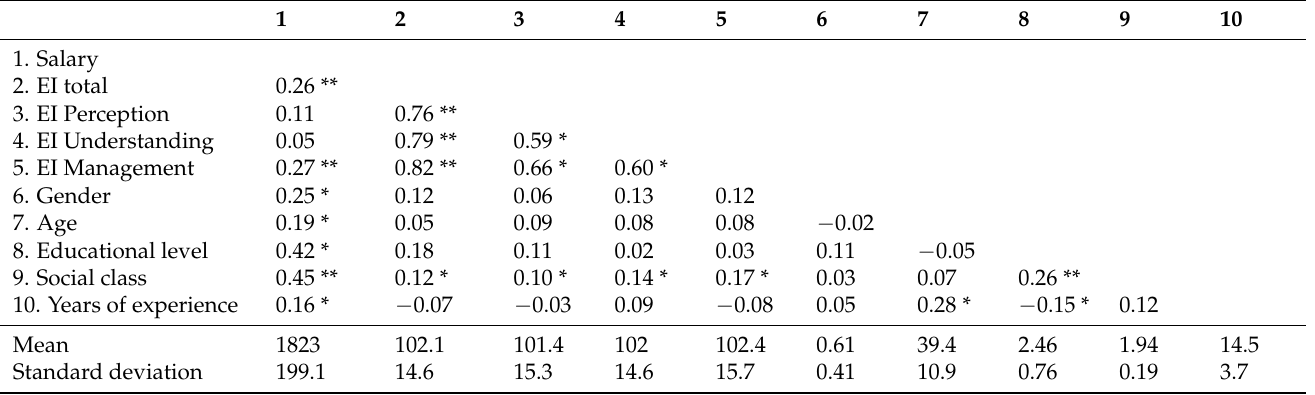
Table 3. Mean, standard deviation and correlations between the study